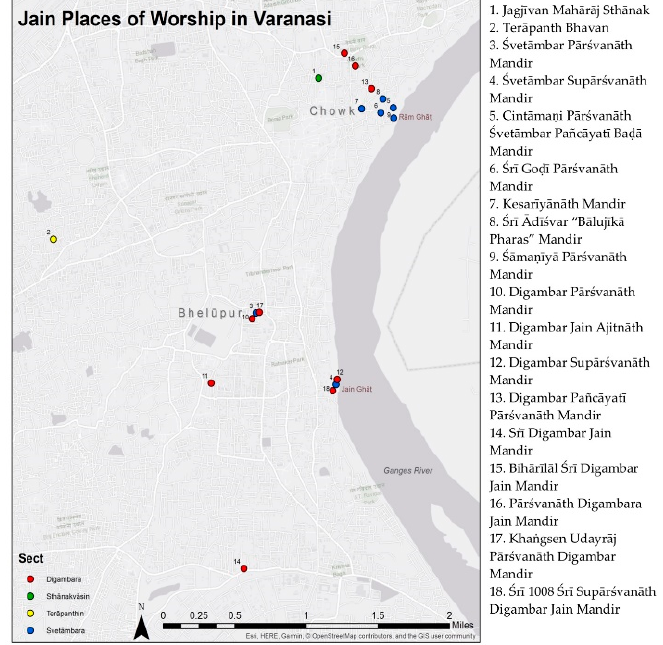
Figure 4. Map of Jain places of worship in Varanasi. Created by Megan Slemons at the Emory Center for Digital Scholarship. Table 1. Sth¯anakv¯asin places of worship in Varanasi.